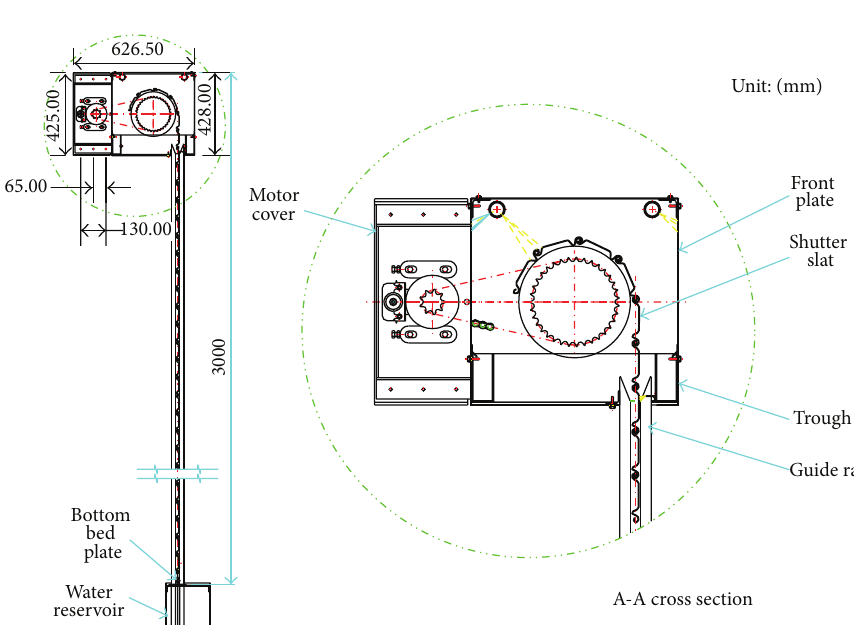
Figure 5: Cross section along AA in Figure